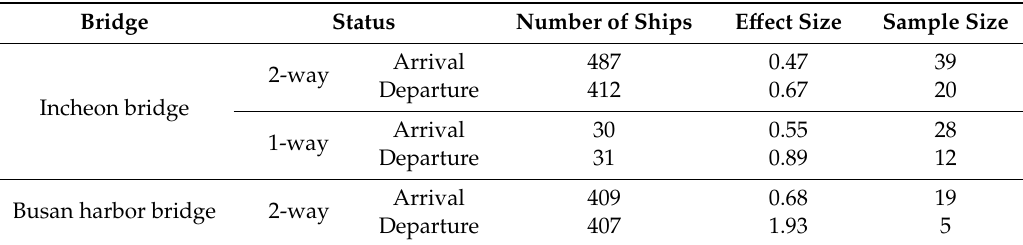
Table 8. Sample size verification by sample power calculation (one-sample t